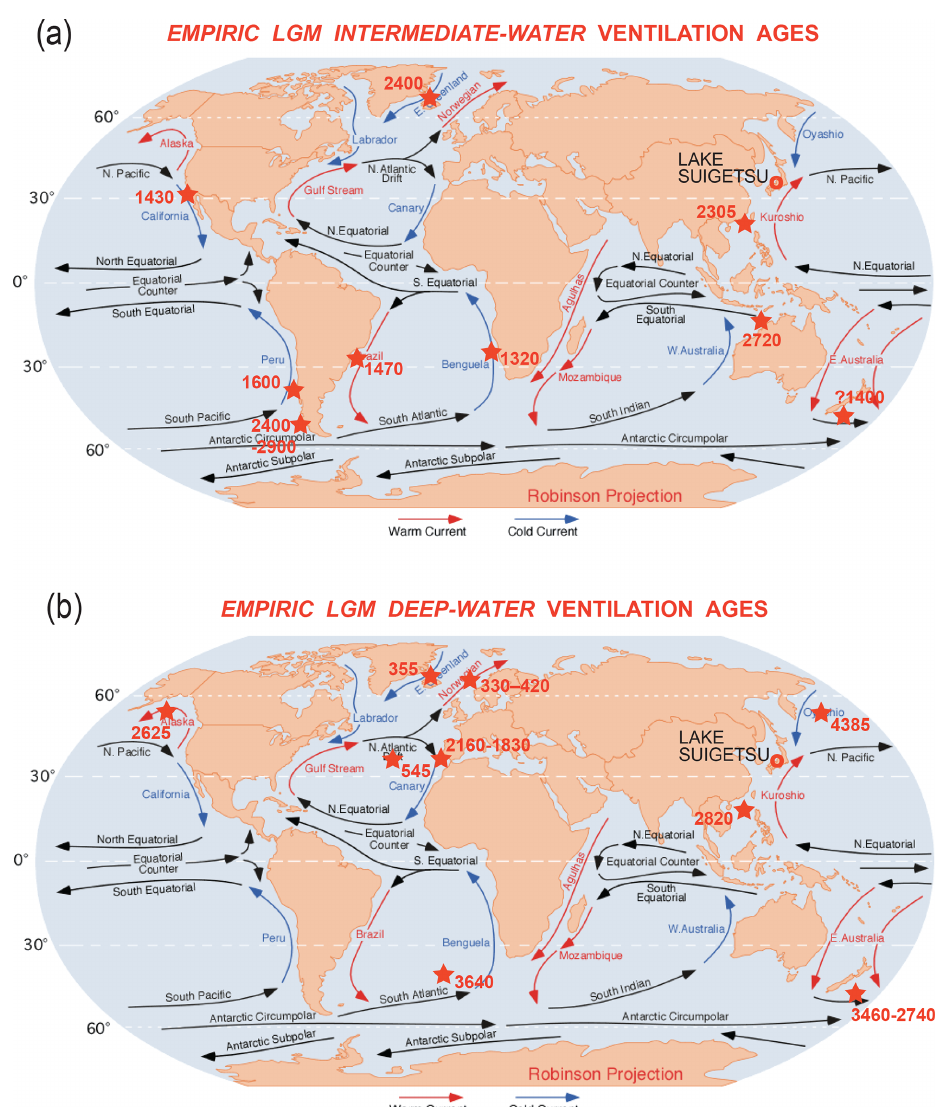
Figure 11. Global distribution of 14 C reservoir ages obtained (a) for late LGM intermediate waters (100–1800mw.d.) and (b) for LGM deep waters ( > 1800mw.d., including Site GIK 23074 at 1157m in the Norwegian